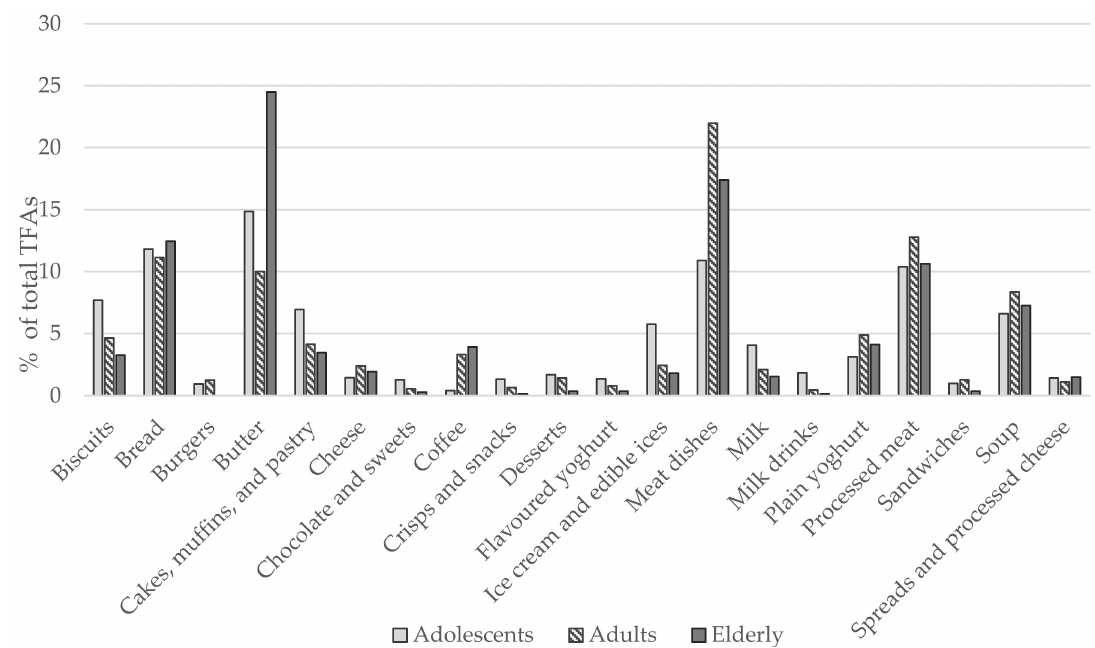
Figure 2. Relative contribution of food categories to trans fatty acid (TFA) intake among different age groups (% of total TFAs intake). Note: “Coffee” category also includes coffee drinks that can contain milk or